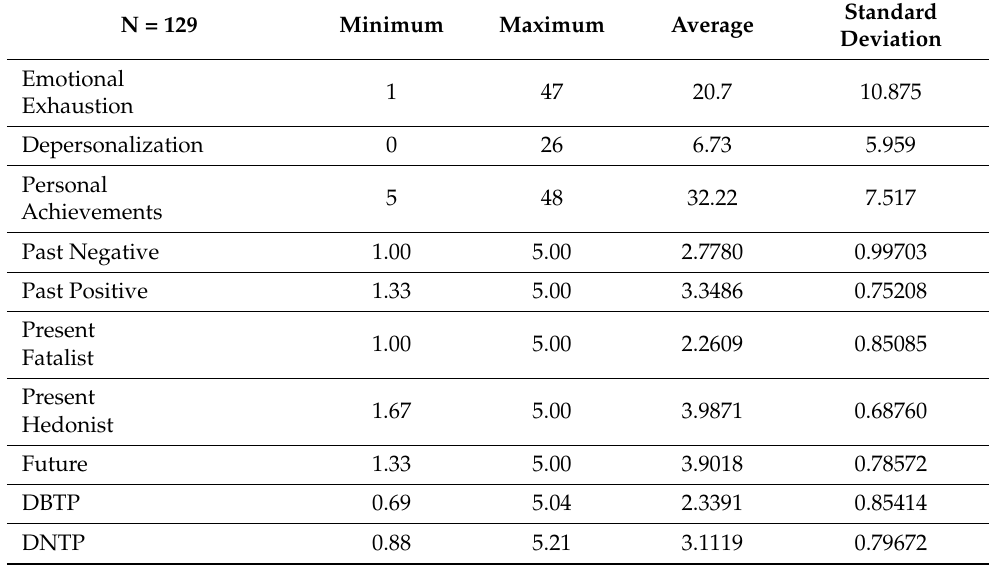
Table 4. Basic statistic calculations for N = 129.